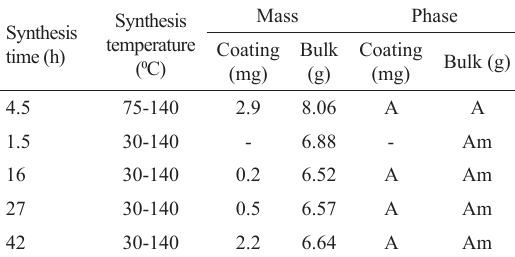
Table 4: Masses and phases of coatings and bulk phase solid materials obtained by substrate heating method (A: zeolite A, Am: amorphous